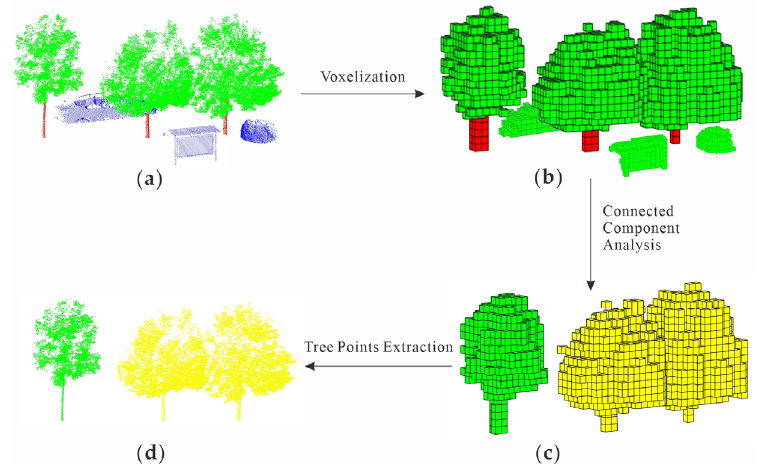
Figure 5. Tree point extraction based on the voxel connectivity analysis: ( a ) point clouds acquired by MLS; ( b ) the result of voxelization; ( c ) the outcome of the voxel connectivity analysis; ( d ) the extracted tree points.